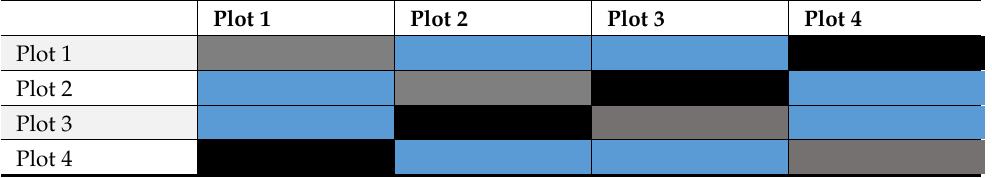
Table 5. Adjacency matrix corresponding to the given farm, with blue cells indicating adjacent plots and black cells non-adjacent plots.